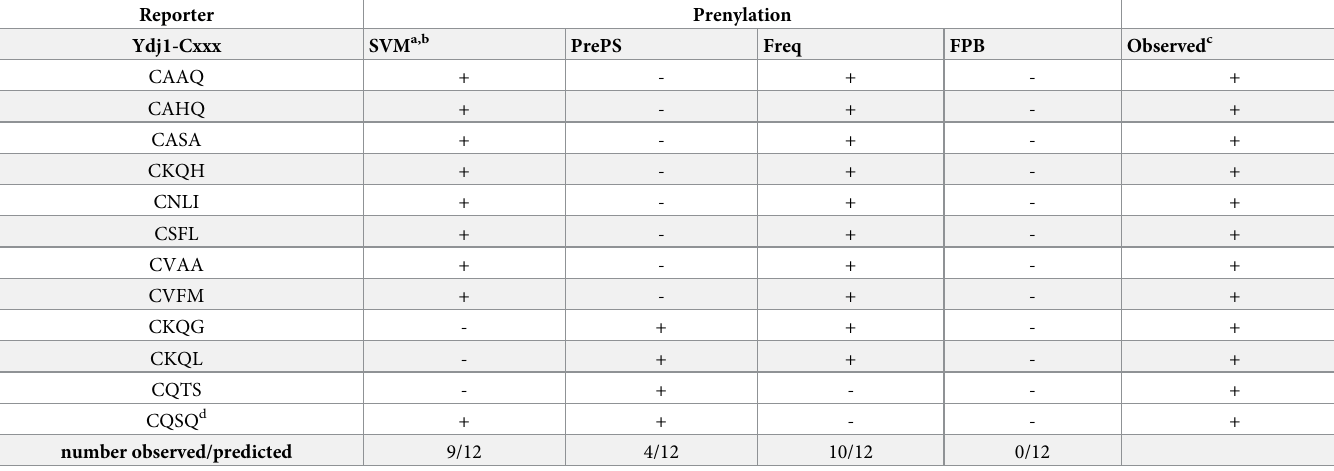
Table 4. Comparison of SVM-ESM-1b and PrePS prenylation predictions with empirical observations.